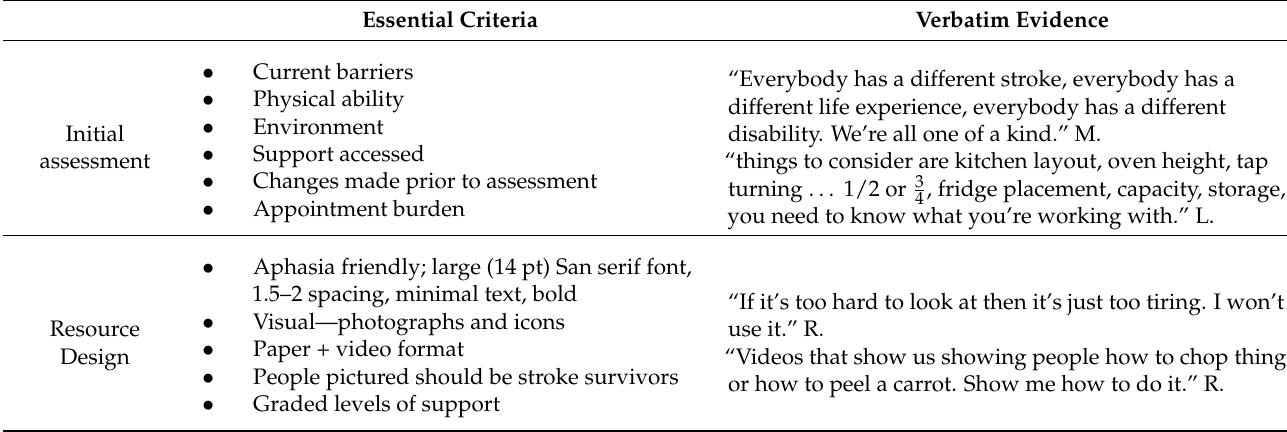
Table 2. Thematic Analysis of Workshop 1 ( n =